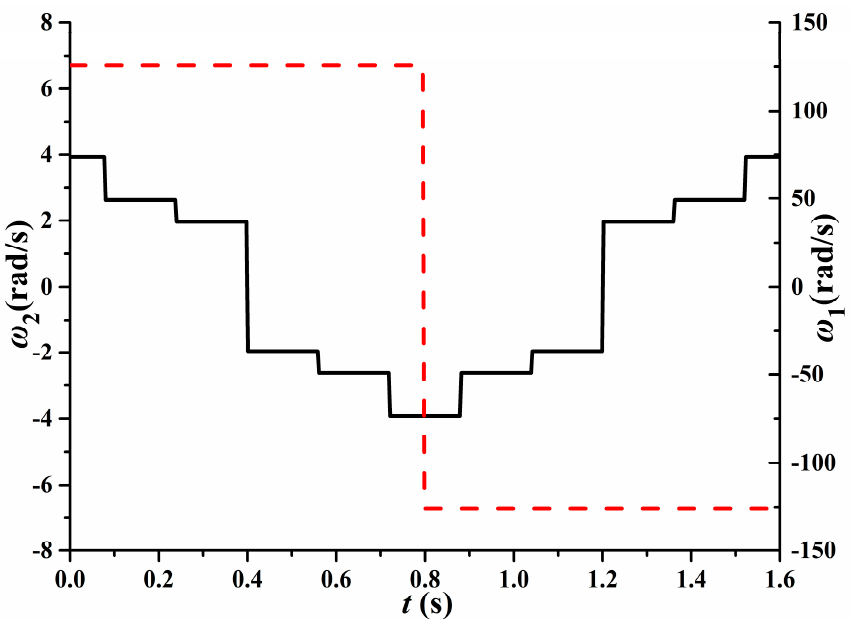
Figure 4. Angular velocities of the linear stepper motor ω 1 (the dashed red line) and the stepper motor ω 2 (the solid black line) as a function of time t when the stroke cycle T is 1.6 s.